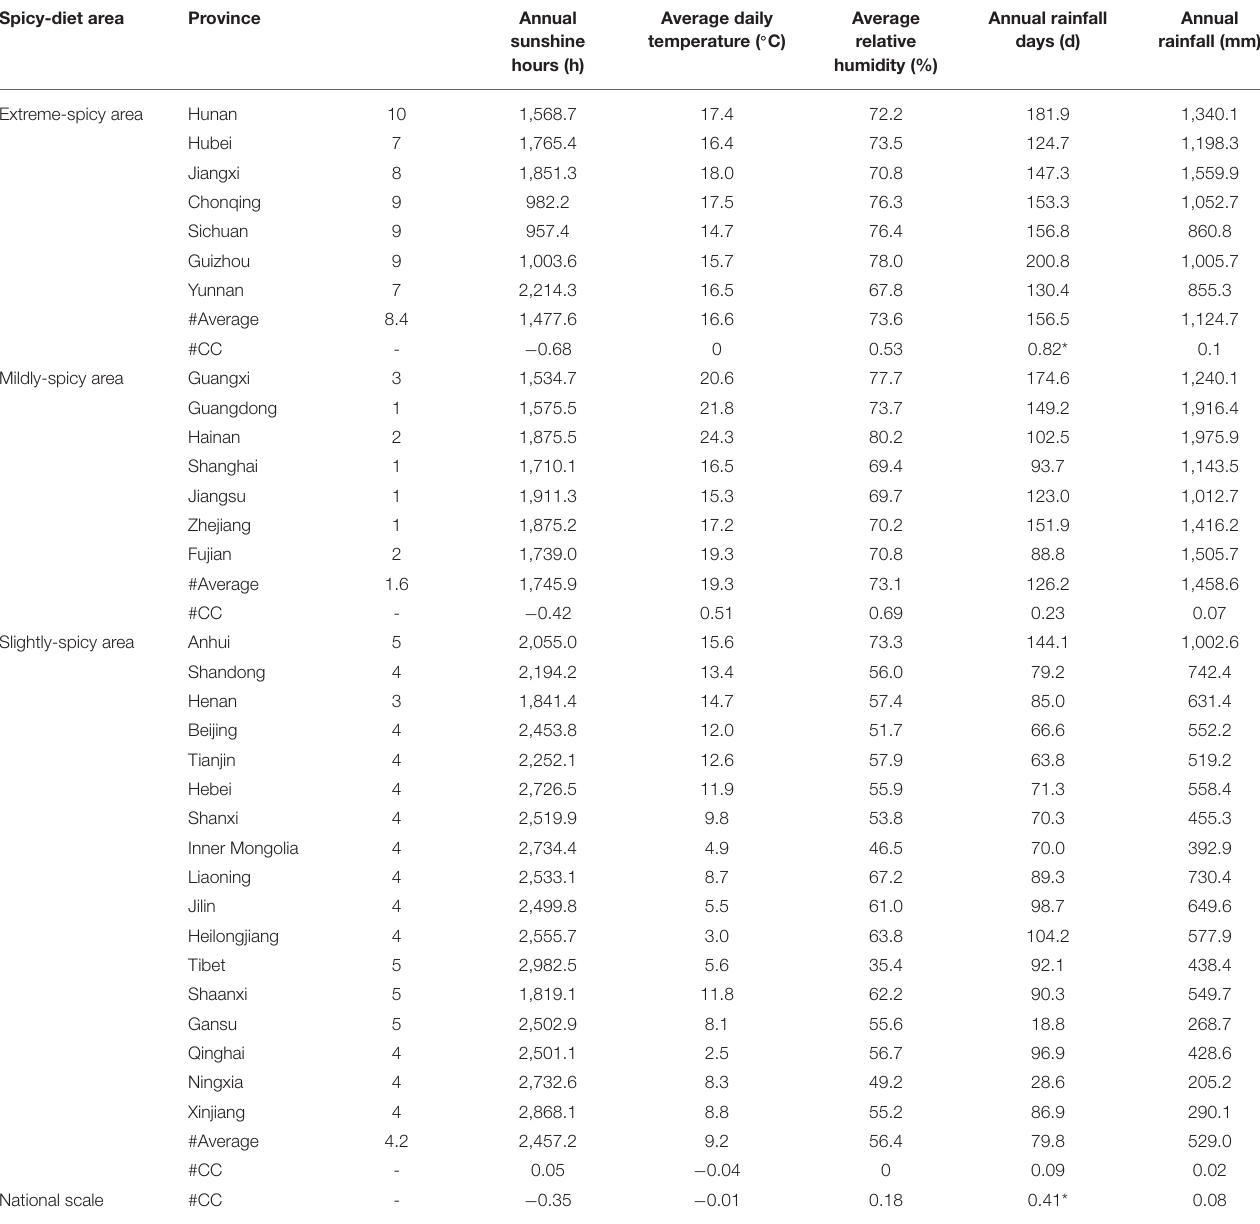
Average daily sunshine temperature ( ◦ C) hours (h)